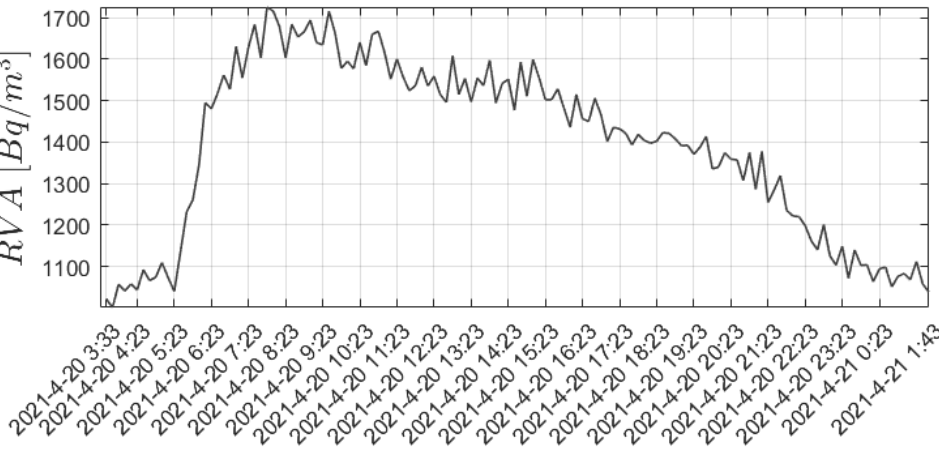
Figure 11. Extracted from the data at the MRZR point Figure 6 burst RVA, lasting 22.5